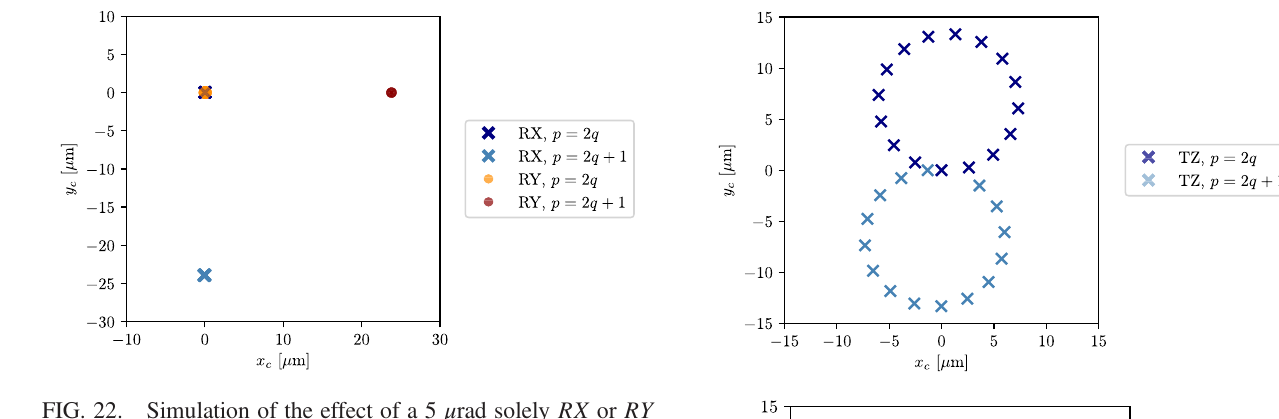
FIG. 22. Simulation of the effect of a 5 μ rad solely RX or RY rotation misalignment of M2 on the circulation trace at the IP. The even dots ( RY , p ¼ 2 q ) and cross ( RX , p ¼ 2 q ) overlap where p is the path number and q ∈ ½ 0 ; 16 (cid:4) .